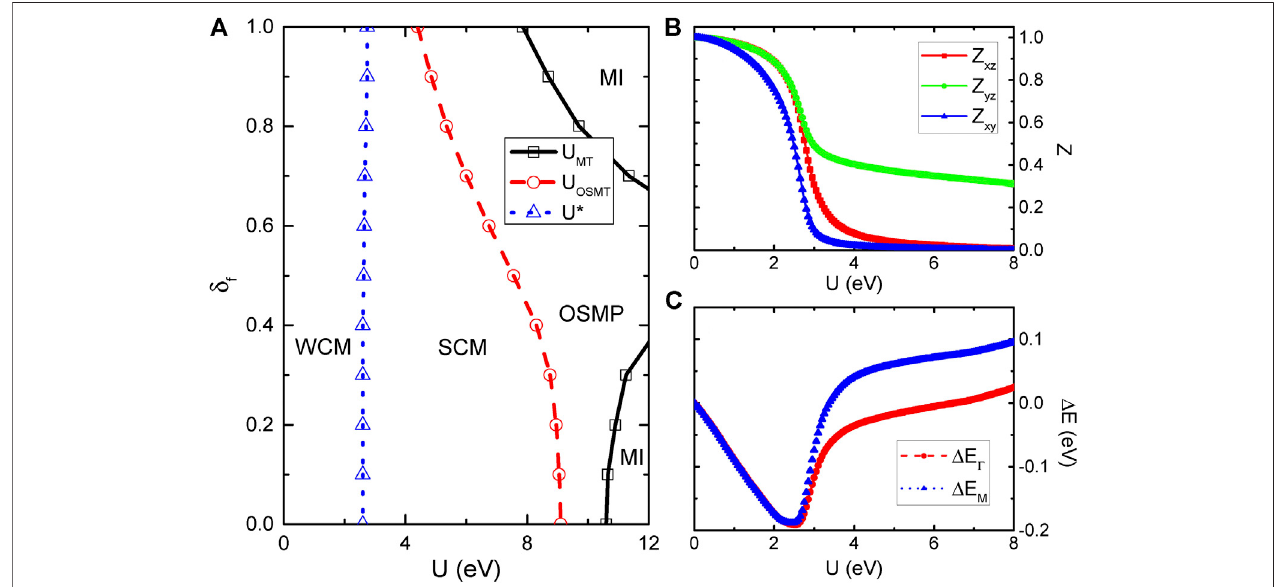
FIGURE 4 | (A) Ground-state phase diagram of the fi ve-orbital Hubbard model for FeSe with a ferro-orbital order δ f at J H / U (cid:2) 0 . 25. (B) The orbital-selective quasiparticle spectral weights in the nematic phase with a combined nematic order δ f / 4 (cid:2) δ d (cid:2) δ s (cid:2) 0 . 2 eV and with J H / U (cid:2) 0 . 25. (C) Band splittings at Γ ( Δ E Γ ) and M ( Δ E M ) points of the 2-Fe BZ in the nematic phase with the same set of parameters as in (B) , adapted from